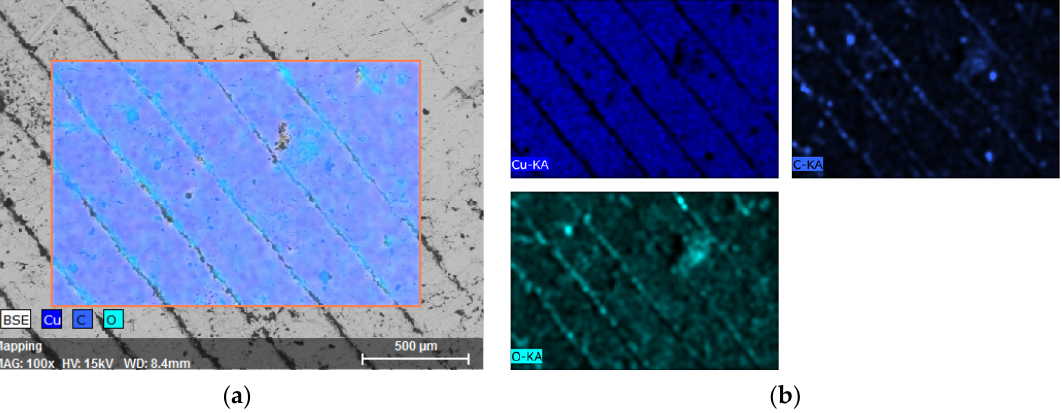
Figure 7. SEM–EDX analysis of the ADAM sample: ( a ) Region selected; ( b ) Identification of elements present on the surface.